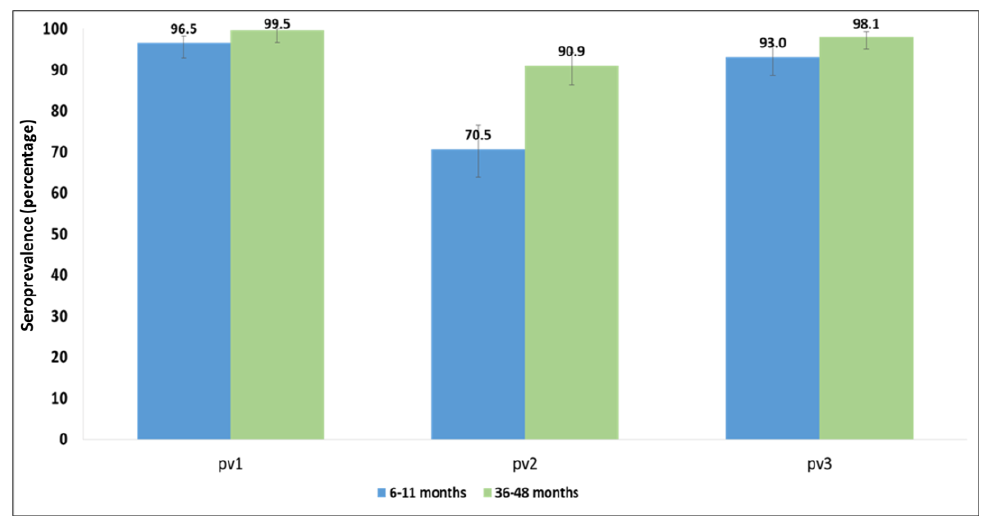
Figure 2. Seroprevalence by age group and poliovirus serotype, Afghanistan, 2017. Percentage is shown above each condition.